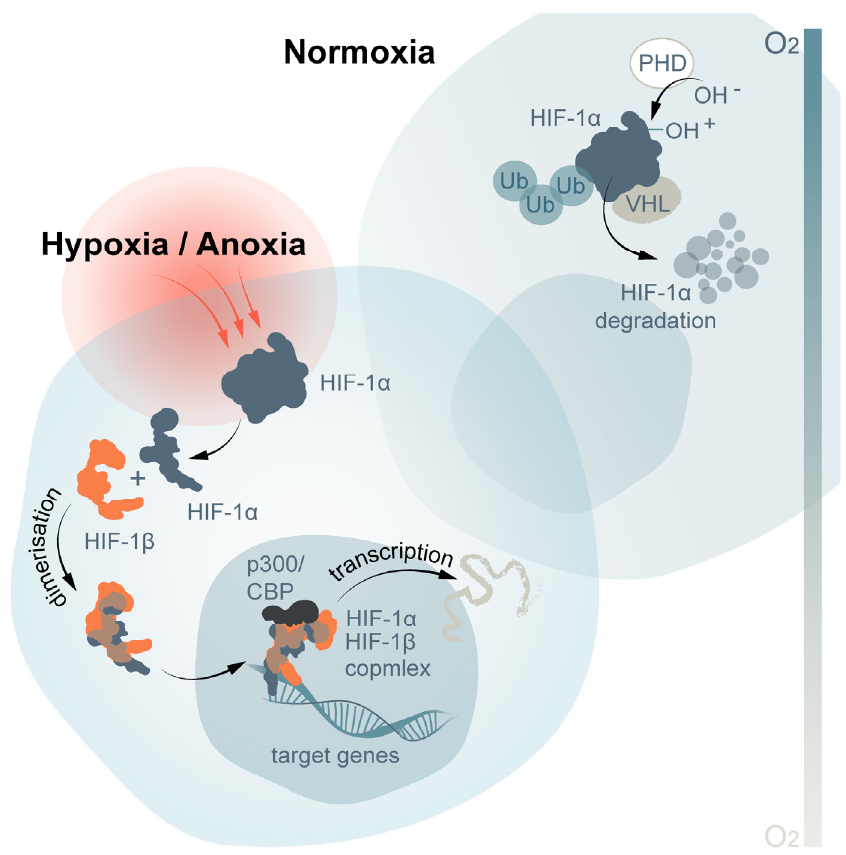
Figure 5. Involvement of HIF-1 in changes of gene expression under hypoxic conditions in bi-